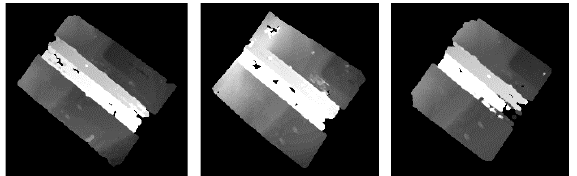
Figure 4. Examples of DSMs from successfully matched